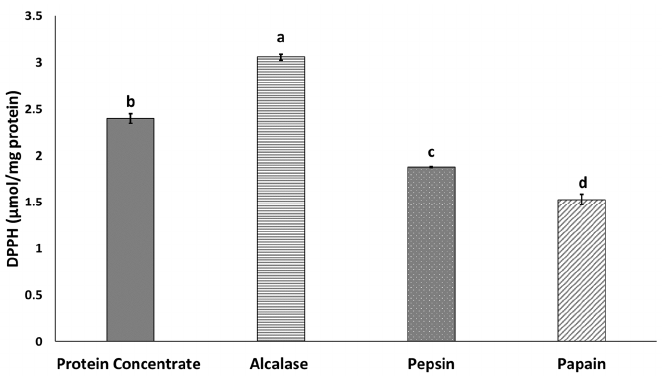
Figure 2. Antioxidant properties of BSF protein hydrolysates. Values with different letters are significantly di ff erent ( p < significantly different ( p < 0.05).